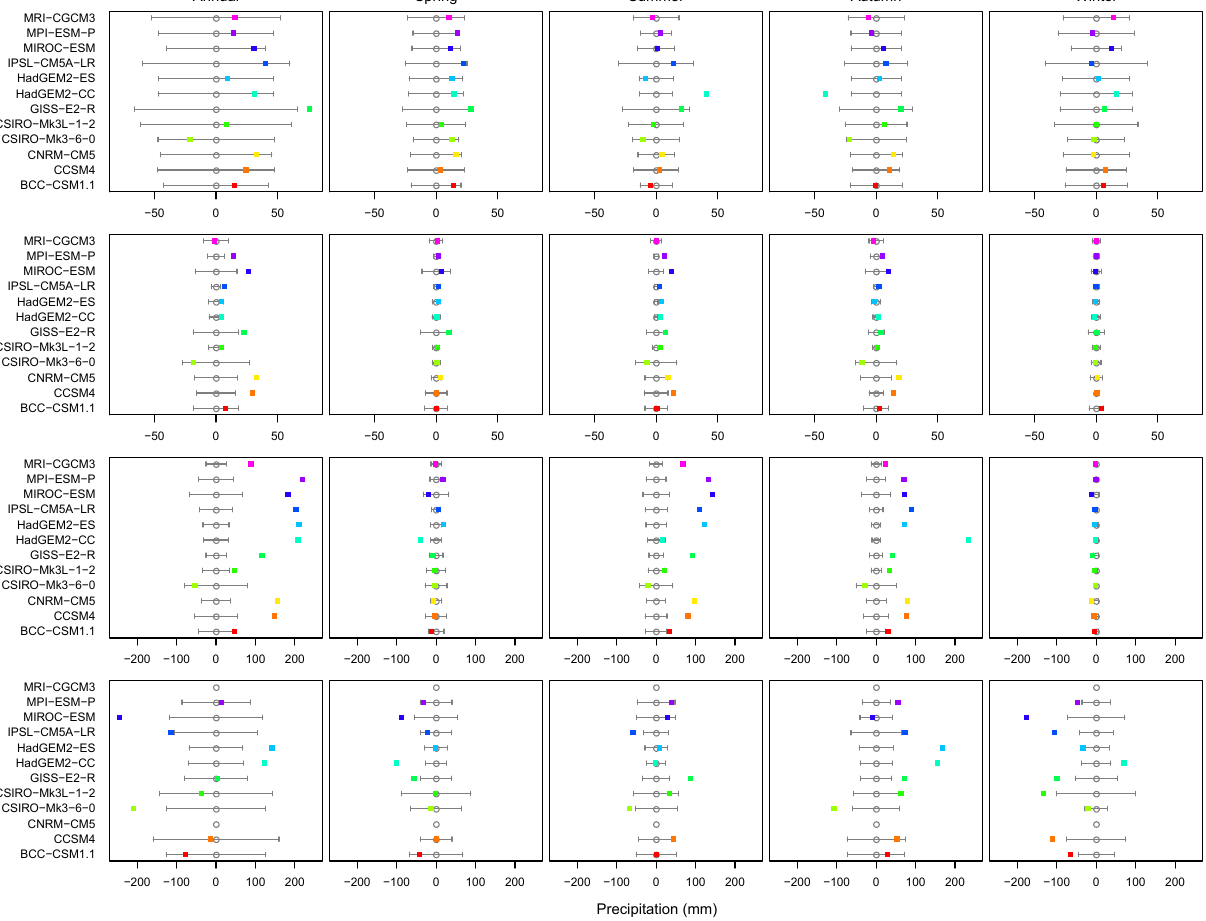
Fig. 5. Simulated changes in total and seasonal precipitation in the midHolocene compared to the piControl for each of the four precipitation regimes (Mediterranean, desert, monsoon, double peak) for the region that is common between the two sets of simulations. The standard de- viation of precipitation in the piControl control simulation of each model is shown (grey bars) to provide a visual measure of the significance of the simulated change in precipitation. The seasons are defined as spring, summer, autumn and winter (as in Sect.